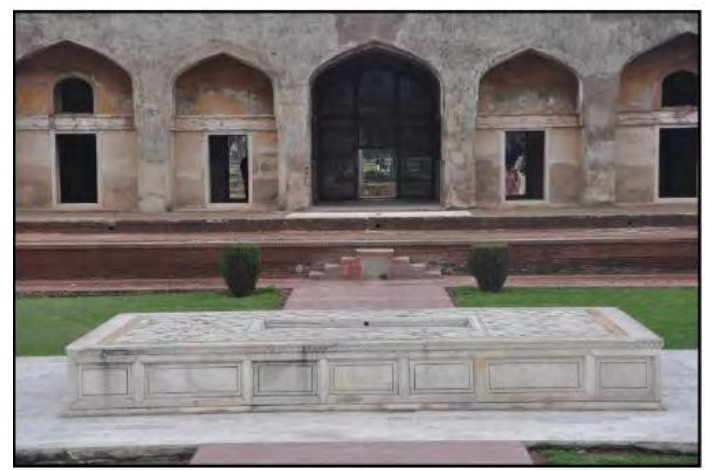
Figure 9. Fountain in courtyard in front of Khilwat Khana